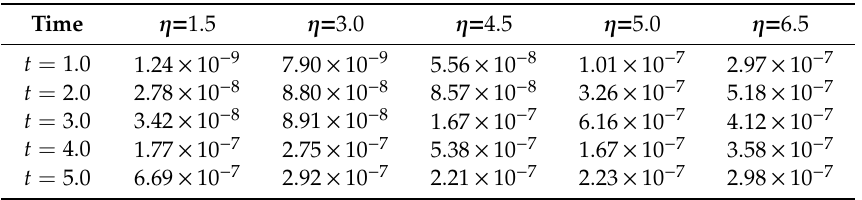
Table 3. RMSEs for di ff erent η